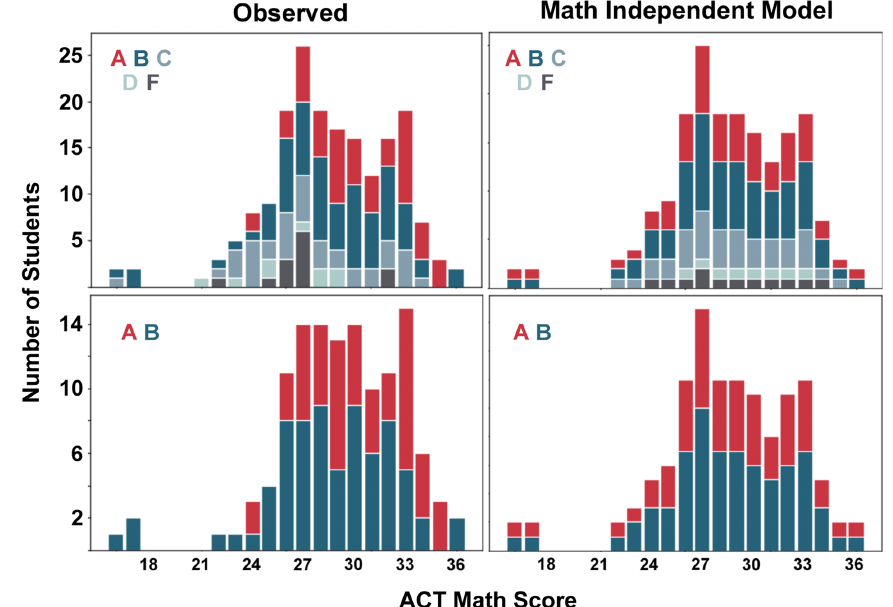
FIG. 5. The observed and predicted ACT math score distributions for students who completed PHSX 210. The left figures are the observed distributions and the right figures are the distributions expected if course grade is independent of ACT math score. The top shows the distributions for all course grades and the bottom rows are the distributions for students earning an A or a B. and predicted distributions is better for the PHSX 211 cohort than for the PHSX 210 cohort, completion of PHSX 211 reduces the predictive power of ACT math scores on student grade in ME 211.